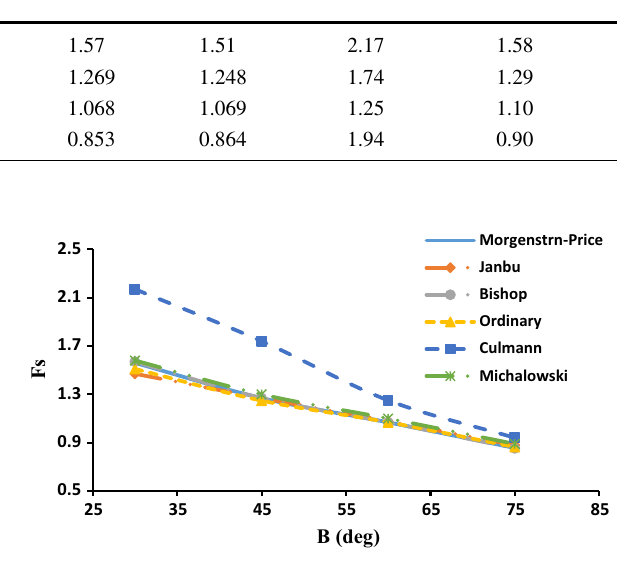
Fig. 10 Comparison of six methods for F